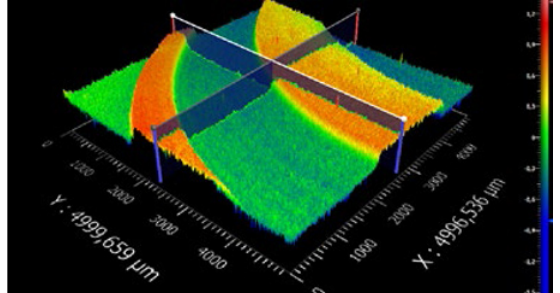
Fig.6. WLI: footprint tool: face grinding